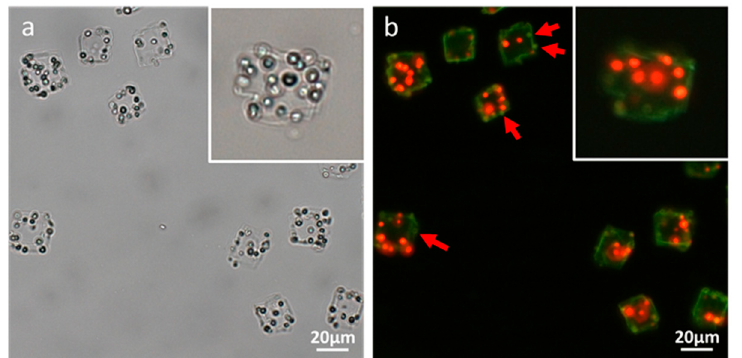
Figure 6. Optical-microscopic images of polymer microcapsules encasing microalgal cells in ( a ) bright-field and ( b ) fluorescence modes. The red and green fluorescences in ( b ) originated from the autofluorescence of the microalgae’s chlorophyll and the LbL coating’s DHR123, respectively.